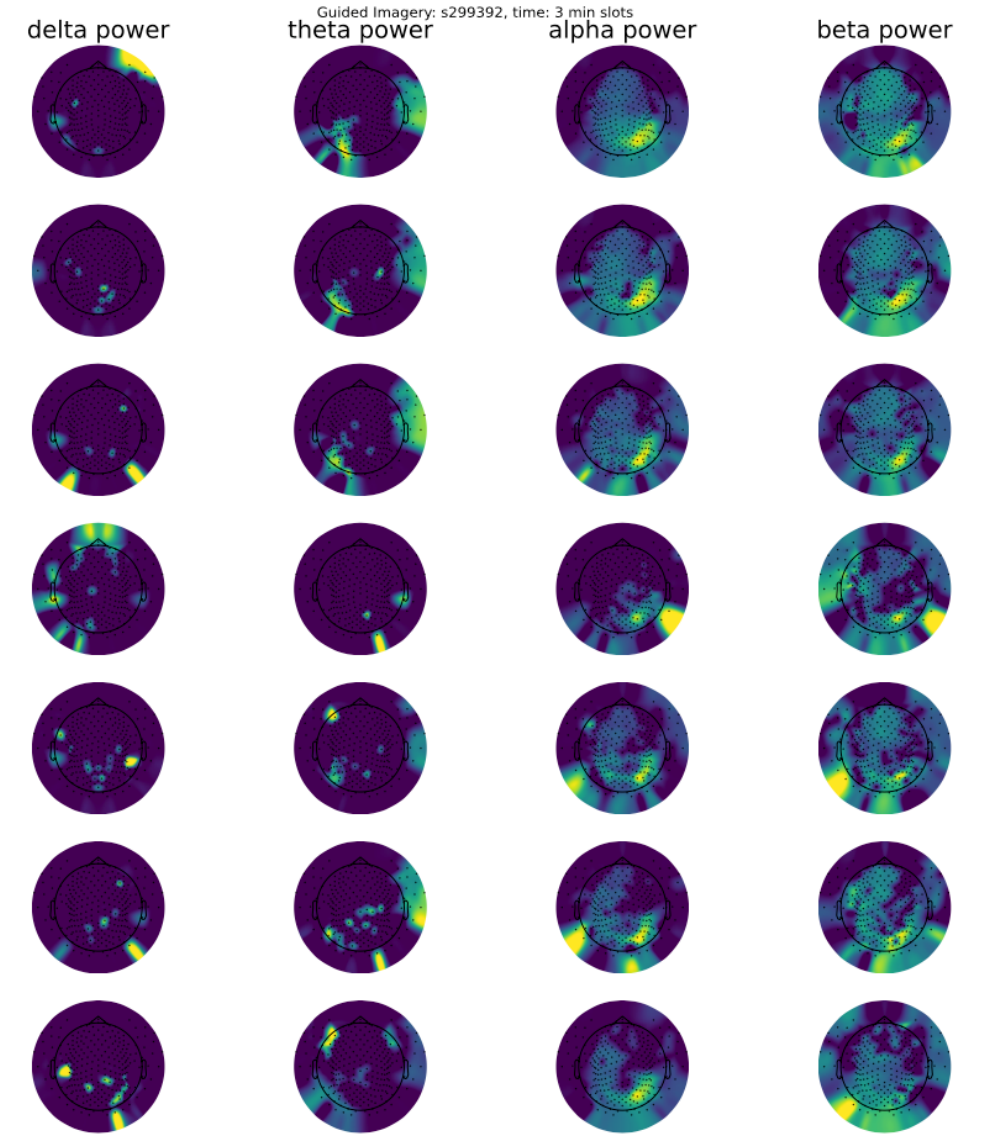
Figure 2. Power activity in the δ , θ , α , and β bands for participant s299392 exposed to guided imagery. Each row, one-by-one, represents a 3-min slot, for 21-min in total. For details, see the